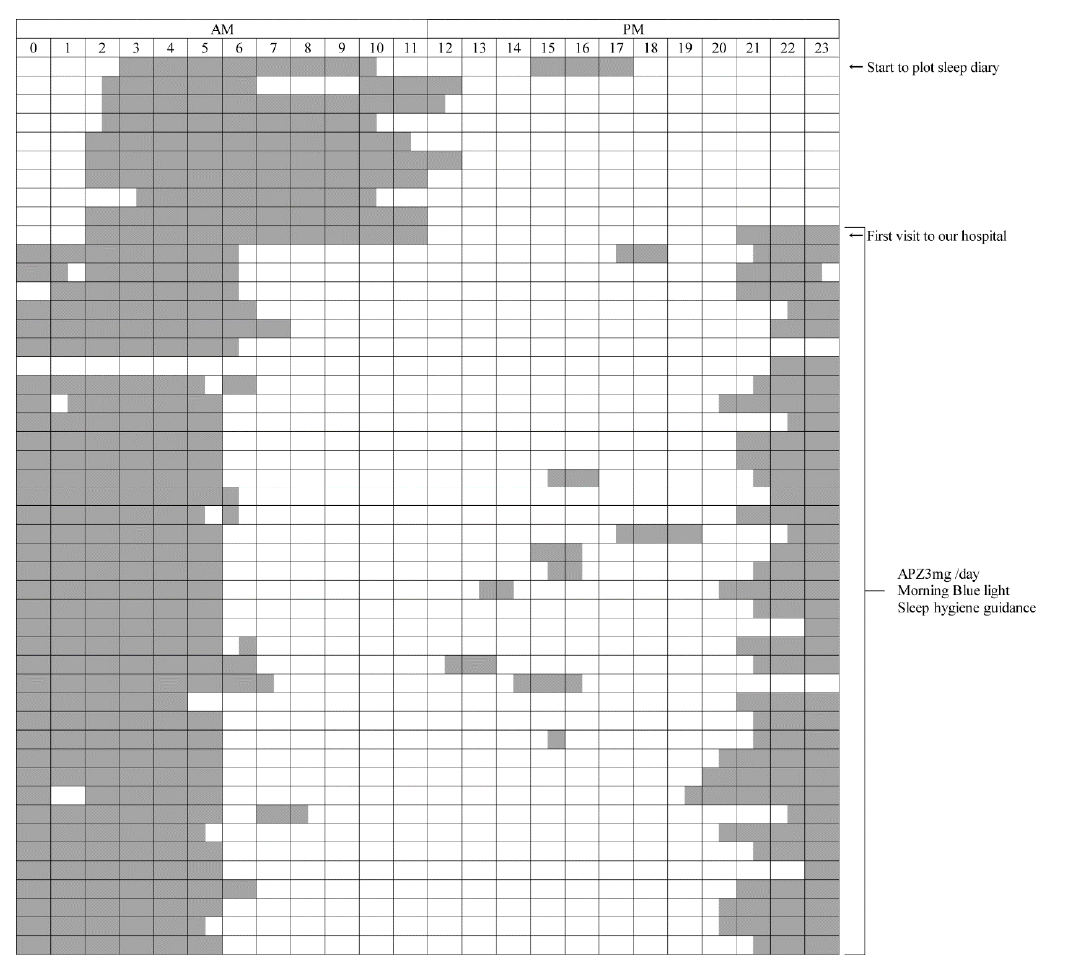
( A ) Summary scores on SF-36